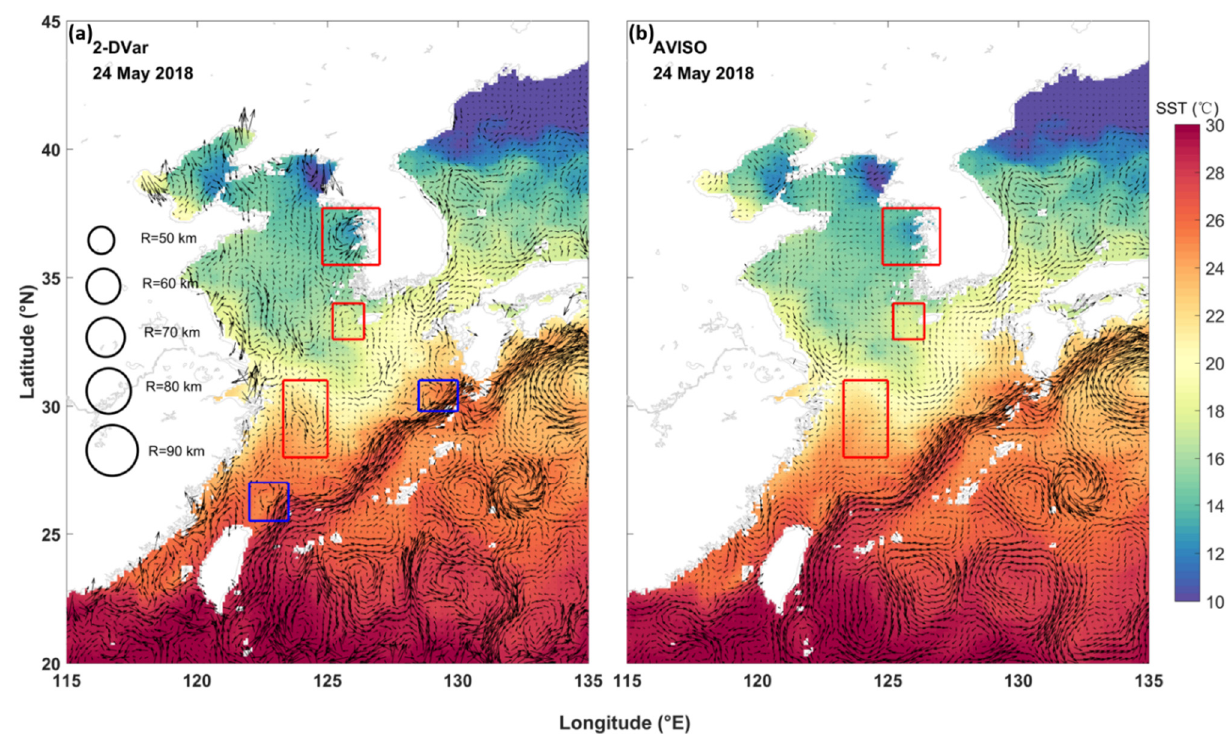
Figure 10. Comparison of the geostrophic current field (vectors) and SST (shaded, °C) on 24 May 2018 between ( a ) 2-DVar and ( b ) AVISO. The red boxes in the two figures denote identified small- scale structures that AVISO does not resolve compared to 2-DVar. The blue boxes denote identified “anomalous” small-scale structures in 2-DVar. The black circles illustrate eddy sizes with radii of 50 to 90 km.